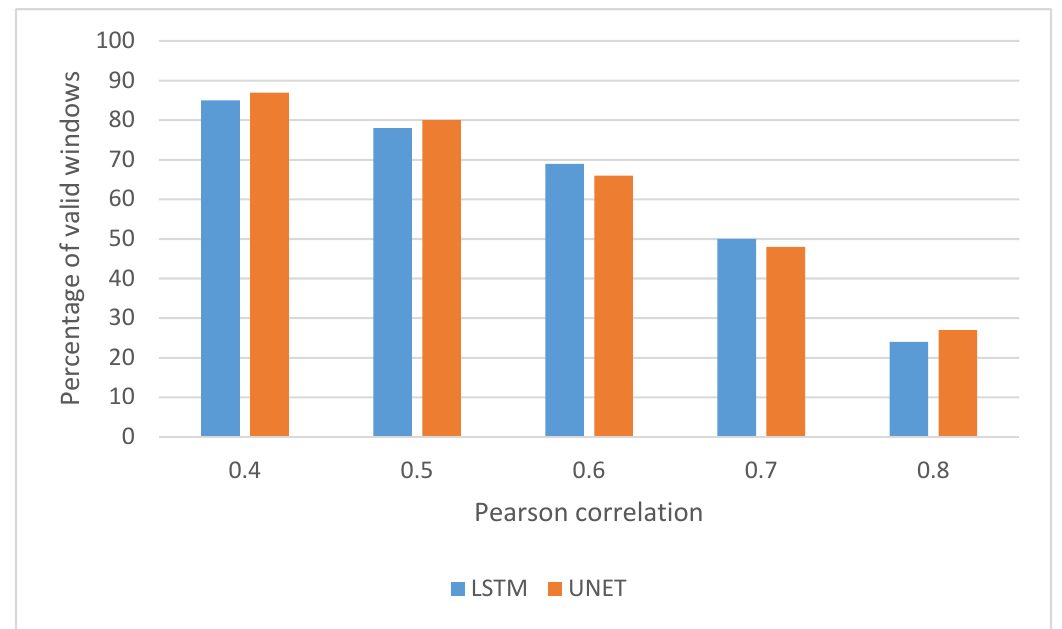
Figure 4. Percentage of valid windows exceeding corresponding Pearson correlation with the reference signal for the Long Short-Term Memory (LSTM) and U-shaped network (U-Net.) The paired t-test between derived and gold standard metrics for all people and respiratory rates are reported in Table 2. Table 2. Paired t-test between derived and gold standard metrics for all people and respiratory rates. Metric Reference